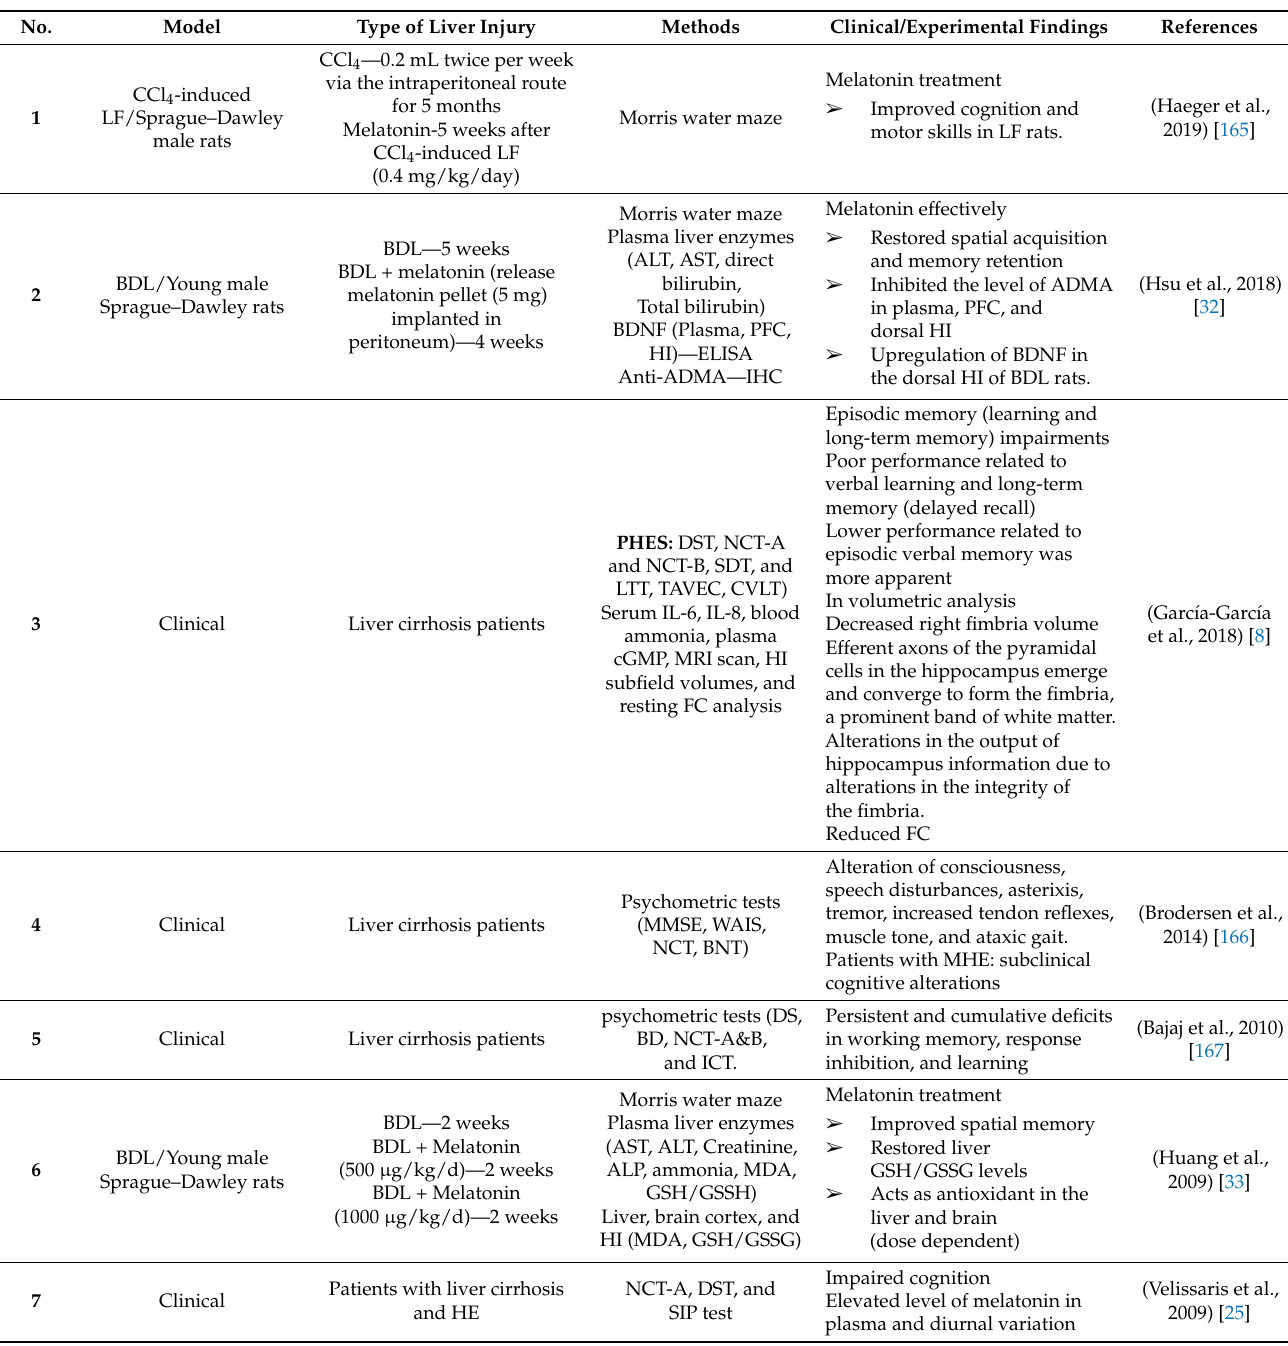
Table 2. Effects of melatonin on HE with cognitive